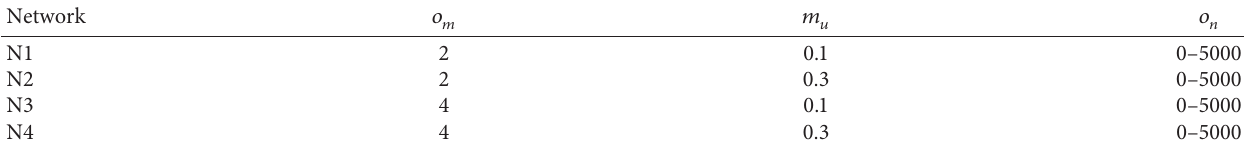
Table 3: Data information of LFR